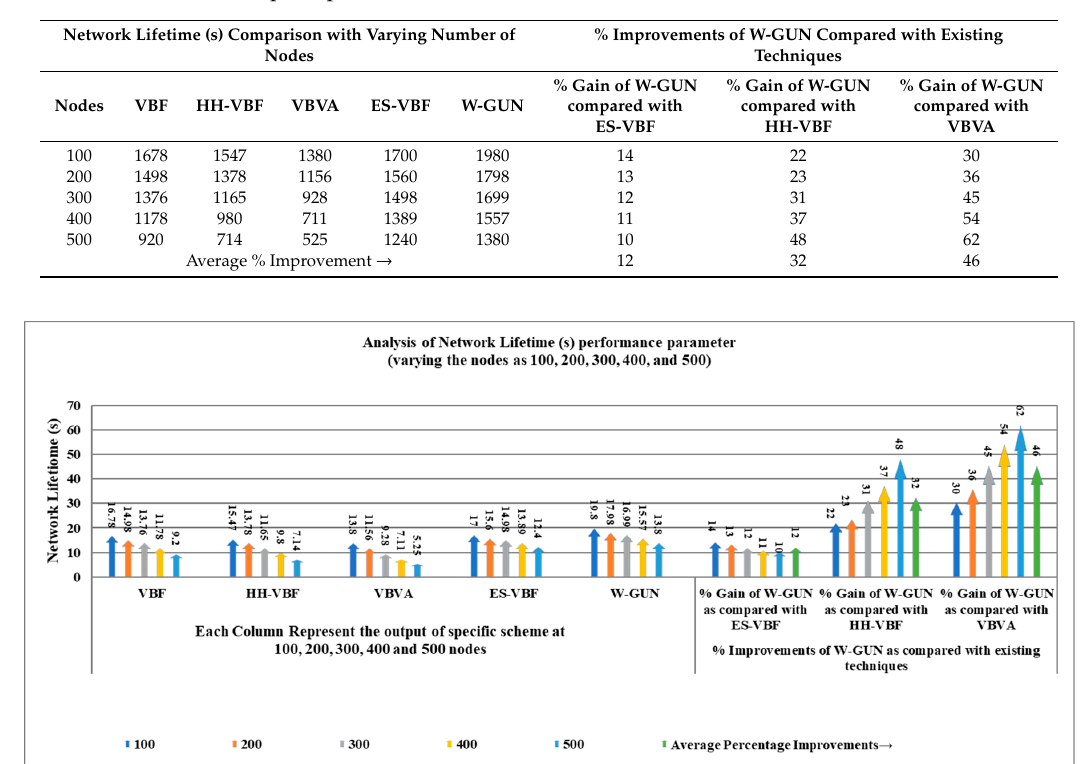
Figure 9. Network lifetime versus the number of underwater nodes. Table 4. Descriptive performance observation of W-GUN in terms of network lifetime.